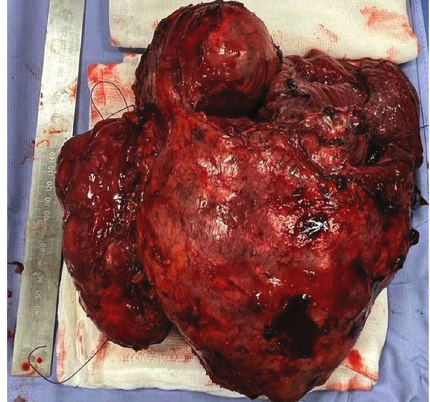
Figure 3: Intraoperative image following resection of an invasive thymoma with right extrapleural pneumonectomy, reconstruction of the superior vena cava and left brachiocephalic vein with expanded-polytetra fl uoroethylene grafts, and replacement of the pericardium with an expanded-polytetra fl uoroethylene